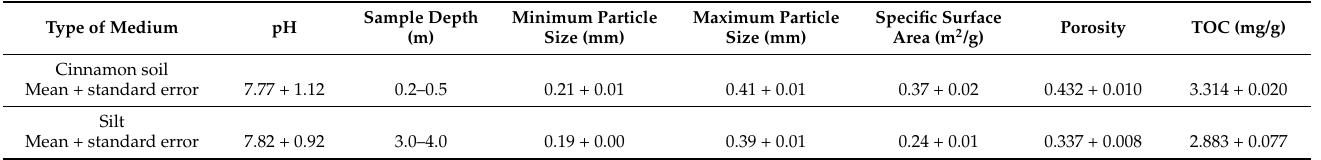
Table 1. Relevant parameters of the research